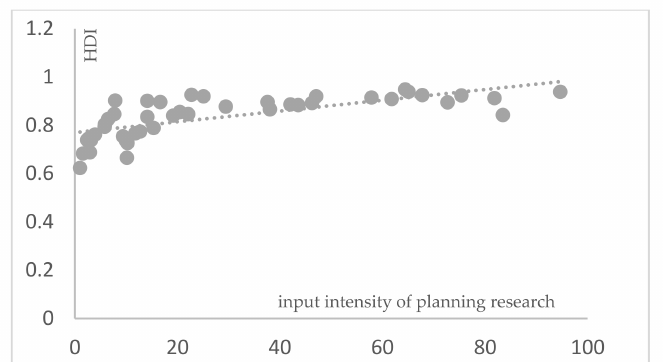
Figure 5. Correlation analysis between input intensity of planning research and HDI [28,30]. Source: based on data from Web of Science and UNDP